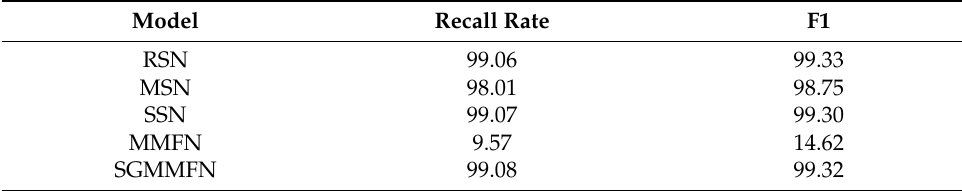
Table 3. Comparison results of recall rate and F1 of different network models.